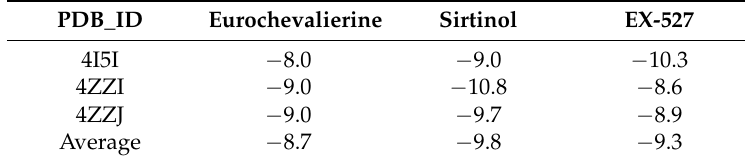
Table 2. Qualitative molecular docking results of eurochevalierine against human SIRT1 1 . PDB_ID Eurochevalierine